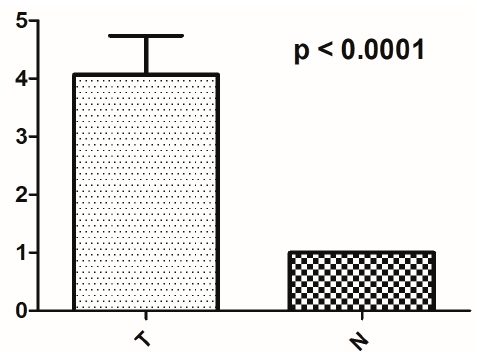
Figure 3. Copy number analysis of mtDNA in thyroid cancer: comparison of the average mtDNA copy number between PTC cases (T) and their corresponding normal tissues (N). Two-sided Mann–Whitney U test was used to analysis the difference, and p < 0.05 was considered as significant.